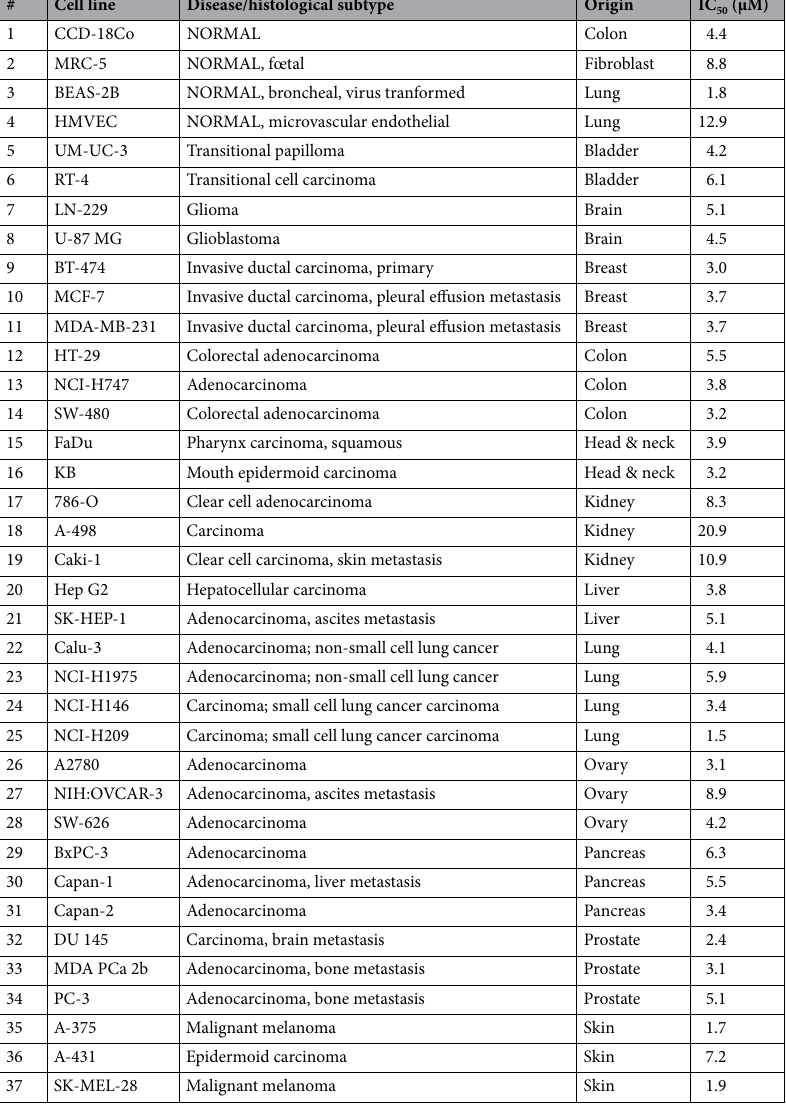
Table 1. IC 50 values of DTT-205 against various cell